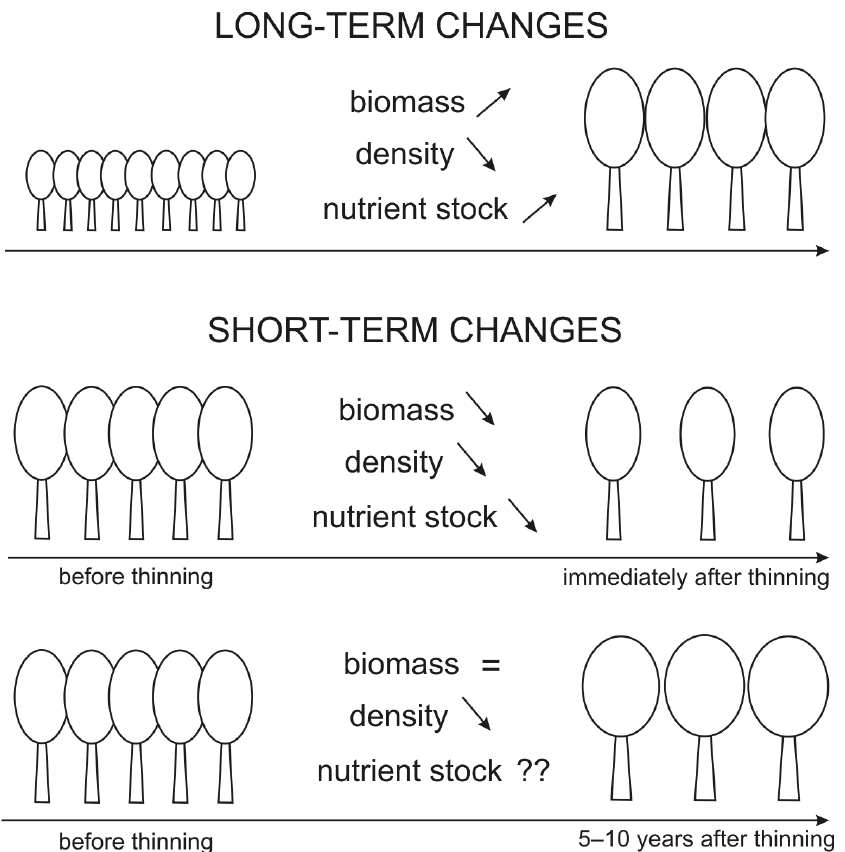
Figure 1. Long-term and short-term changes in aboveground biomass, stand density, and aboveground nutrient stocks in forests.